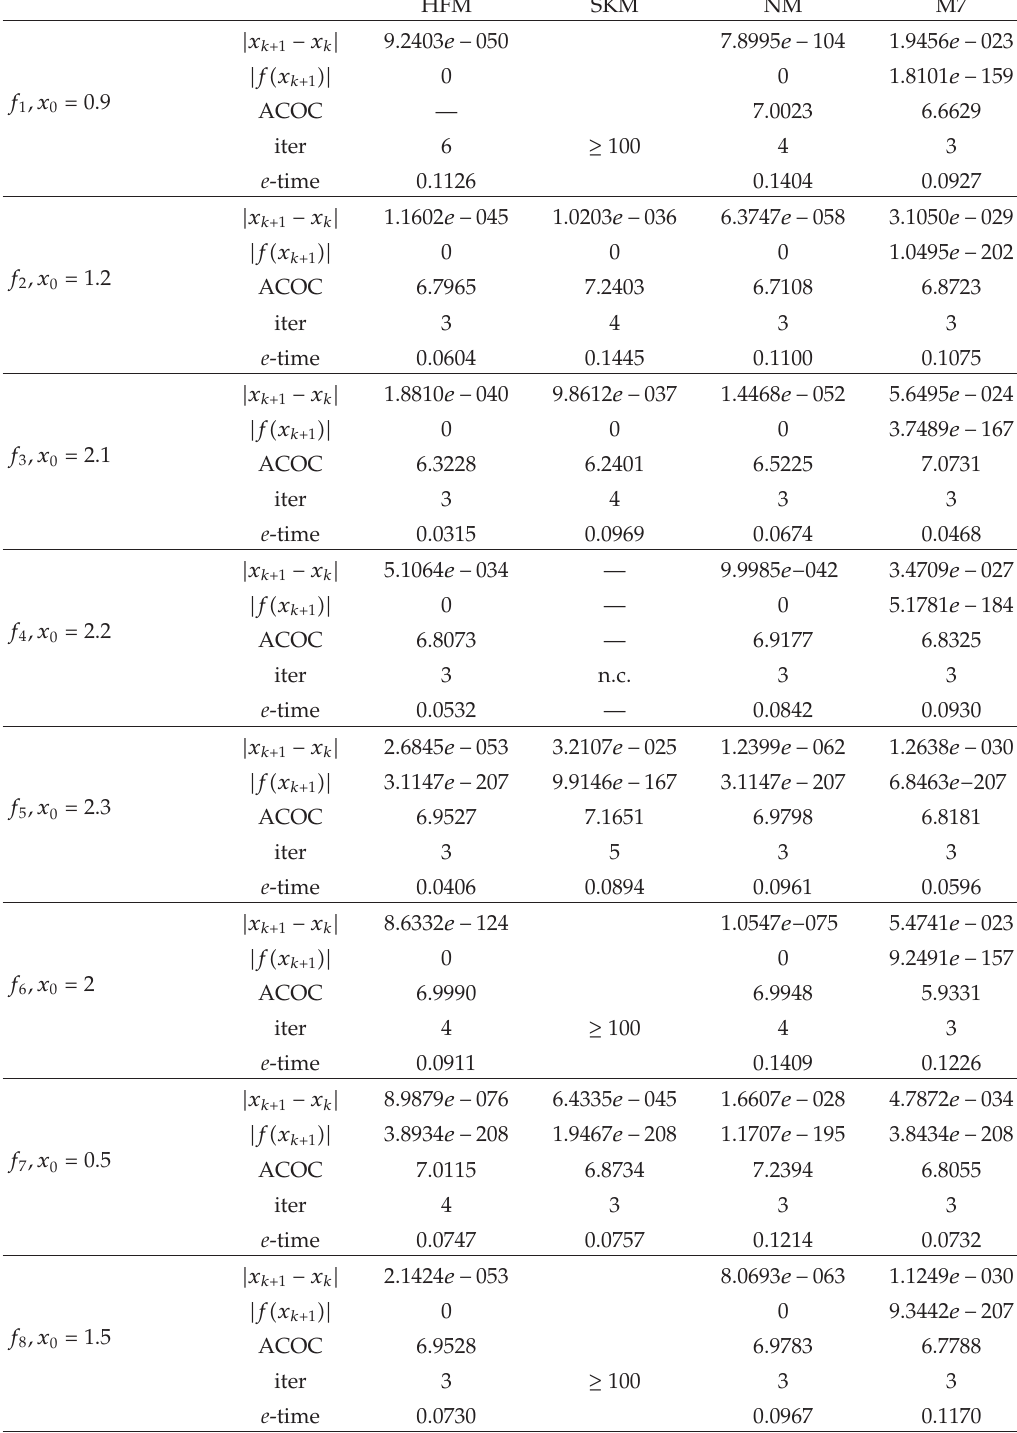
f 1 to 10 and seventh-order schemes. HFM SKM NM